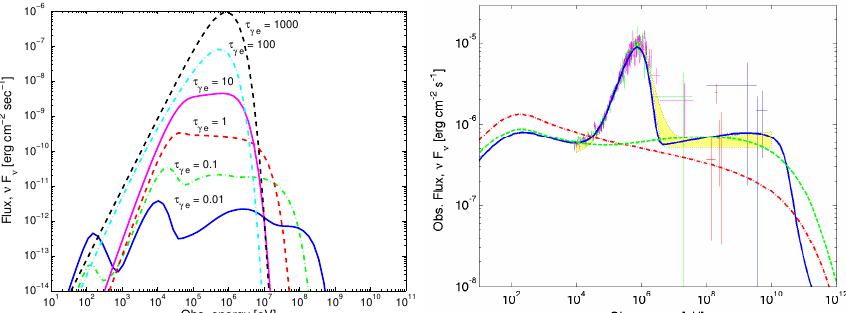
Figure 4. Left: time averaged broadband spectra expected following kinetic energy dissipation at various optical depths. For low optical depth, the two low energy bumps are due to synchrotron emission and the original thermal component, and the high energy bumps are due to inverse Compton. At high optical depth, τ ≥ 100, a Wien peak is formed at 10 keV and is blue-shifted to the MeV range by the bulk Lorentz factor of ∼ 100 expected in GRBs. In the intermediate regime, 0.1 (cid:46) τ (cid:46) 100, a flat energy spectrum above the thermal peak is obtained by multiple Compton scatterings. Figure taken from [194]. ©AAS. Reproduced with permission. Right: spectral decomposition of GRB 090902B (taken 9.6–13.0 s after the GBM trigger) enables clear identification of the physical origin of the emission. The dash-dotted (red) curve shows the spectrum that would have been obtained if synchrotron radiation was the only source of emission. The dashed (green) curve shows the resulting spectrum from synchrotron and synchrotron self-Compton SSC, and the solid (blue) curve shows the spectrum with the full radiative ingredients (synchrotron, SSC, the MeV thermal peak, and Comptonization of the thermal photons). From [206]. Reprinted (and modified) permission of Oxford University Press on behalf of the Royal Astronomical